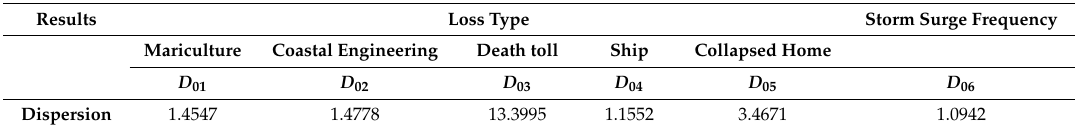
Table 1. Estimated dispersion between direct economic losses and various loss types and storm surge